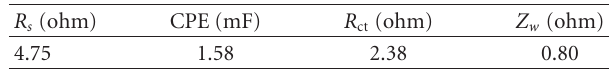
Table 3: Calculated impedance parameters from the equivalent cir- cuit for the methanol oxidation on Pt-Pd/C electrode in solution containing 0.5MNaOH and 1.0M methanol at 140